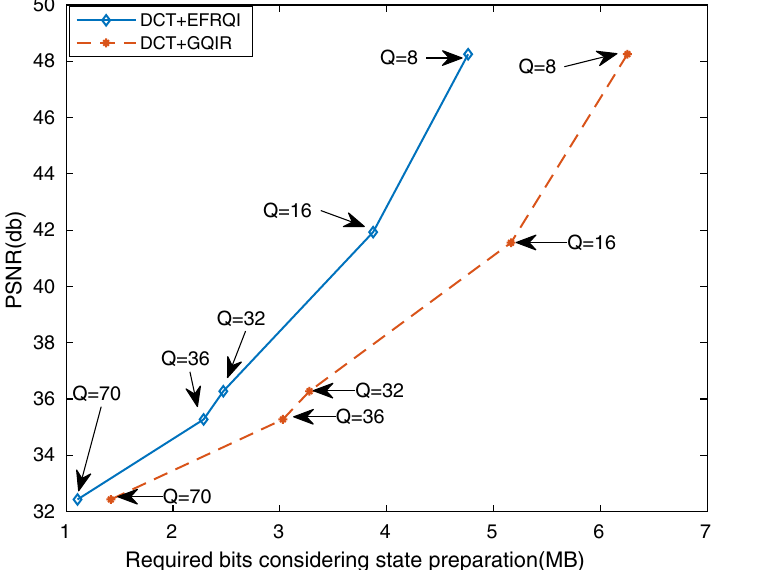
Figure 9. Required bits (MB) versus PSNR (db) for airport